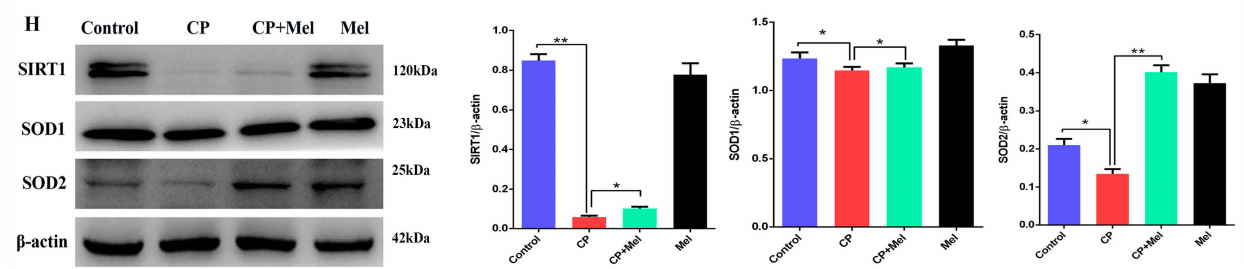
Figure 7. Melatonin could attenuate the downregulation of MT1, MT2, and SIRT1/Nrf2 antioxi- dant signaling by cisplatin in mouse testes. ( A ) Melatonin level in mouse serum. ( B ) Melatonin level in mouse testes. ( C ) Determination of the ASMT and AANAT protein levels was performed by Western blotting in mouse testes. The blots were quantified using Image J software. ( D ) MT1 immunofluorescence in mouse testicular tissue. 3 β -HSD was tagged with green fluorescence, while MT1 was tagged with red fluorescence. The nucleus was labeled with DAPI (scale bar = 20 µ m). ( E ) MT2 immunofluorescence in mouse testicular tissue. 3 β -HSD was tagged with red fluores- cence, while MT2 was tagged with green fluorescence. The nucleus was labeled with DAPI (scale bar = 20 µ m). ( F ) Determination of the MT1 and MT2 protein levels was performed by Western blotting in mouse testes. The blots were quantified using Image J software. ( G ) Determination of Nrf2, HO-1, and NQO1 protein levels was performed by Western blotting in mouse testes. The blots were quantified using Image J software. ( H ) Determination of SIRT1, SOD1, and SOD2 protein levels was performed by Western blotting in mouse testes. The blots were quantified using Image J software. CP, cisplatin. CP + Mel, cisplatin + melatonin. Mel, melatonin. Data are presented as the mean ± SEM ( N = 8 per group). * p < 0.05 compared with controls or CP groups. ** p < 0.01 compared with controls or CP groups.